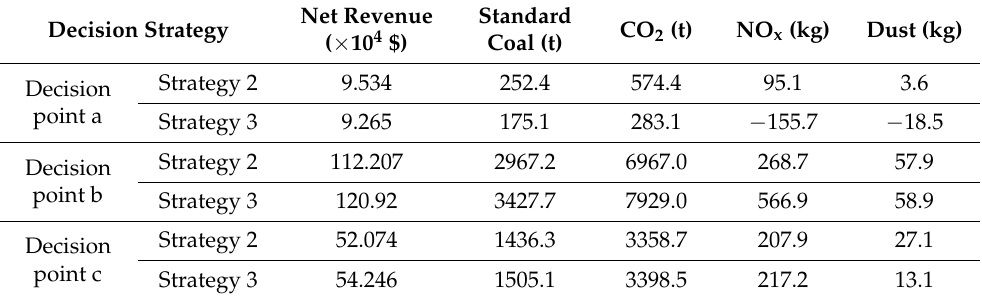
Table 7. The net revenue/coal saving and emission reduction corresponding to the wind energy curtailment strategy.